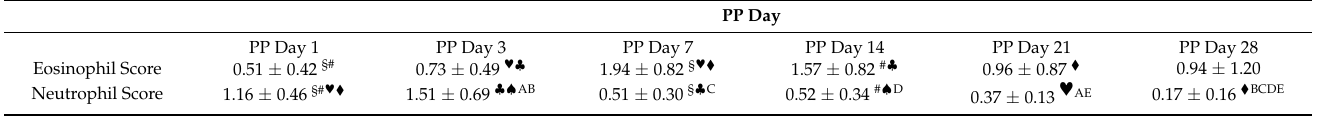
Table 2. Postpartum endometrial glandular number, perimeter, area, and epithelium thickness (mean ± SD) in the different sampling times in the 9 Martina Franca jennies. Table 3. Score (mean ± SD) for postpartum eosinophil and neutrophil cells’ amount evaluation at the different sampling times, in the 9 Martina Franca jennies.